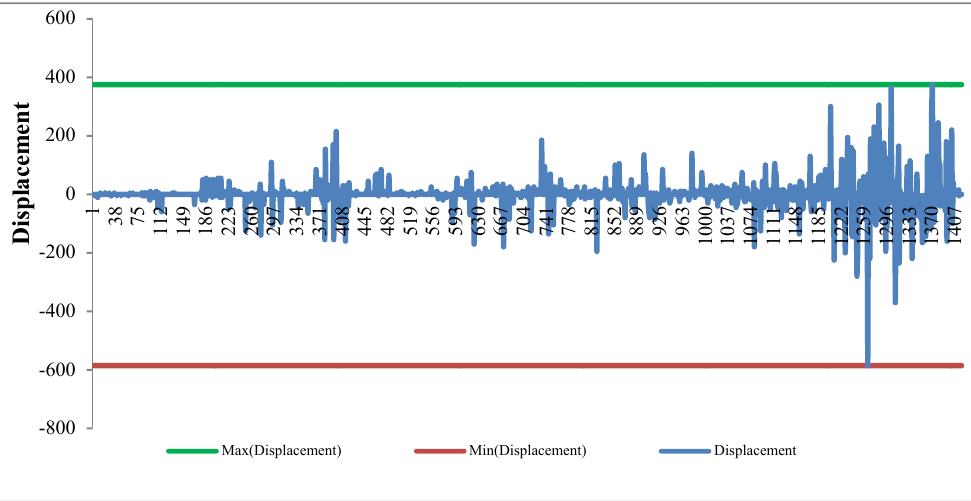
Figure 11. Displacement while weights set as [0,0.5,0.5] in test 8.